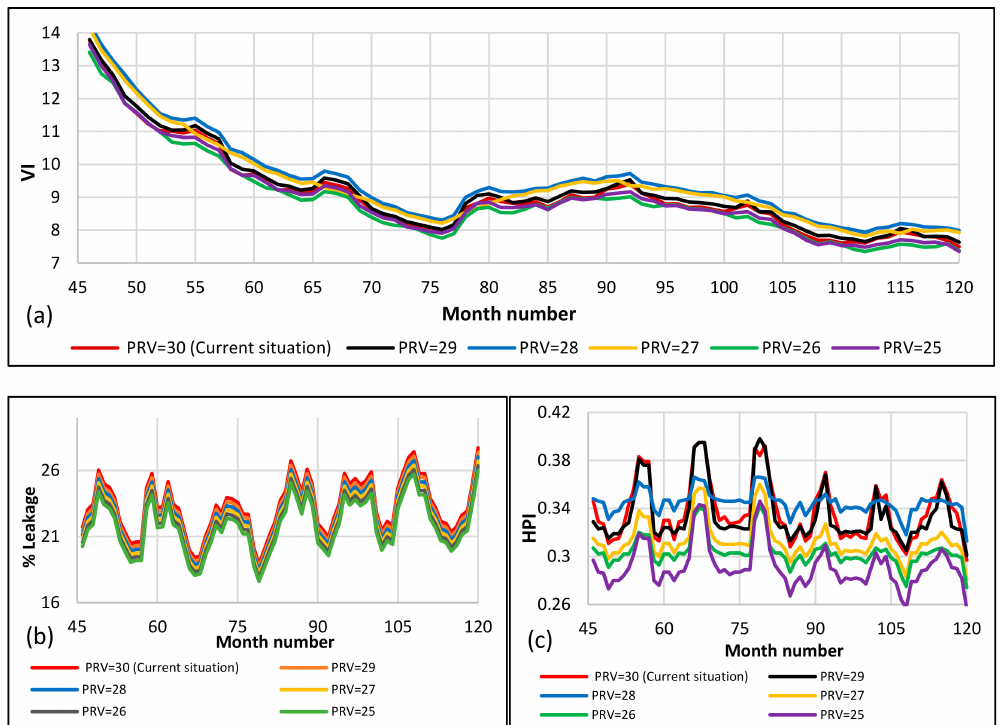
Figure 13. E ff ect of the adjusted pressure of pressure reducing valves (PRV) on: ( a ) VI; ( b ) Leakage; ( c )